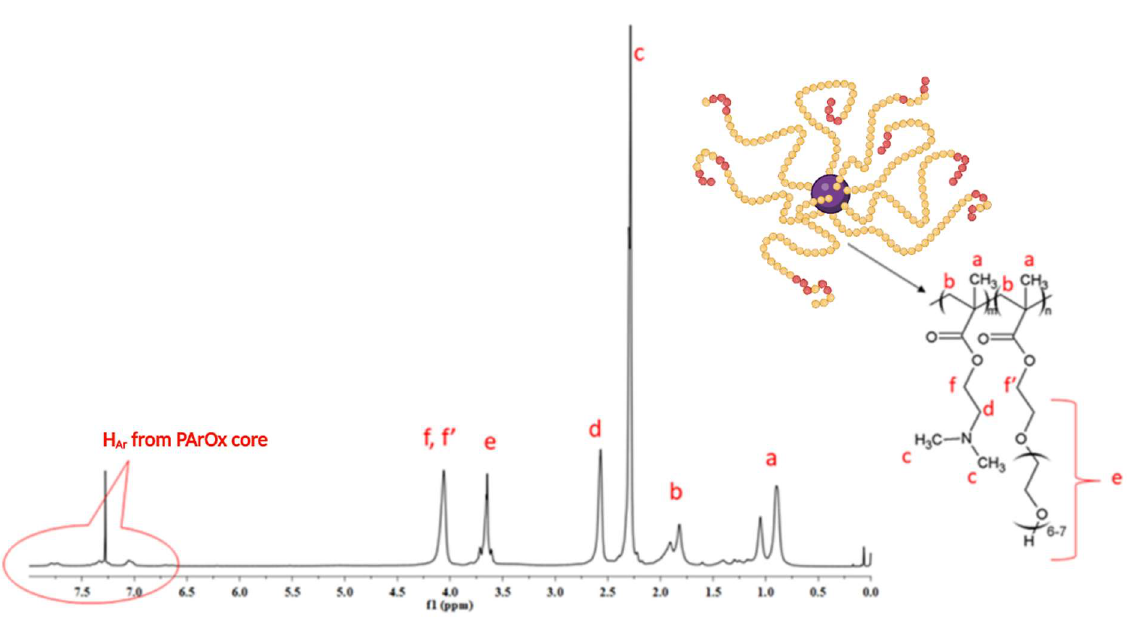
Figure 1. 1 H NMR spectrum of the star copolymer of DMAEMA and OEGMA-OH (CDCl 3 , 600 MHz).